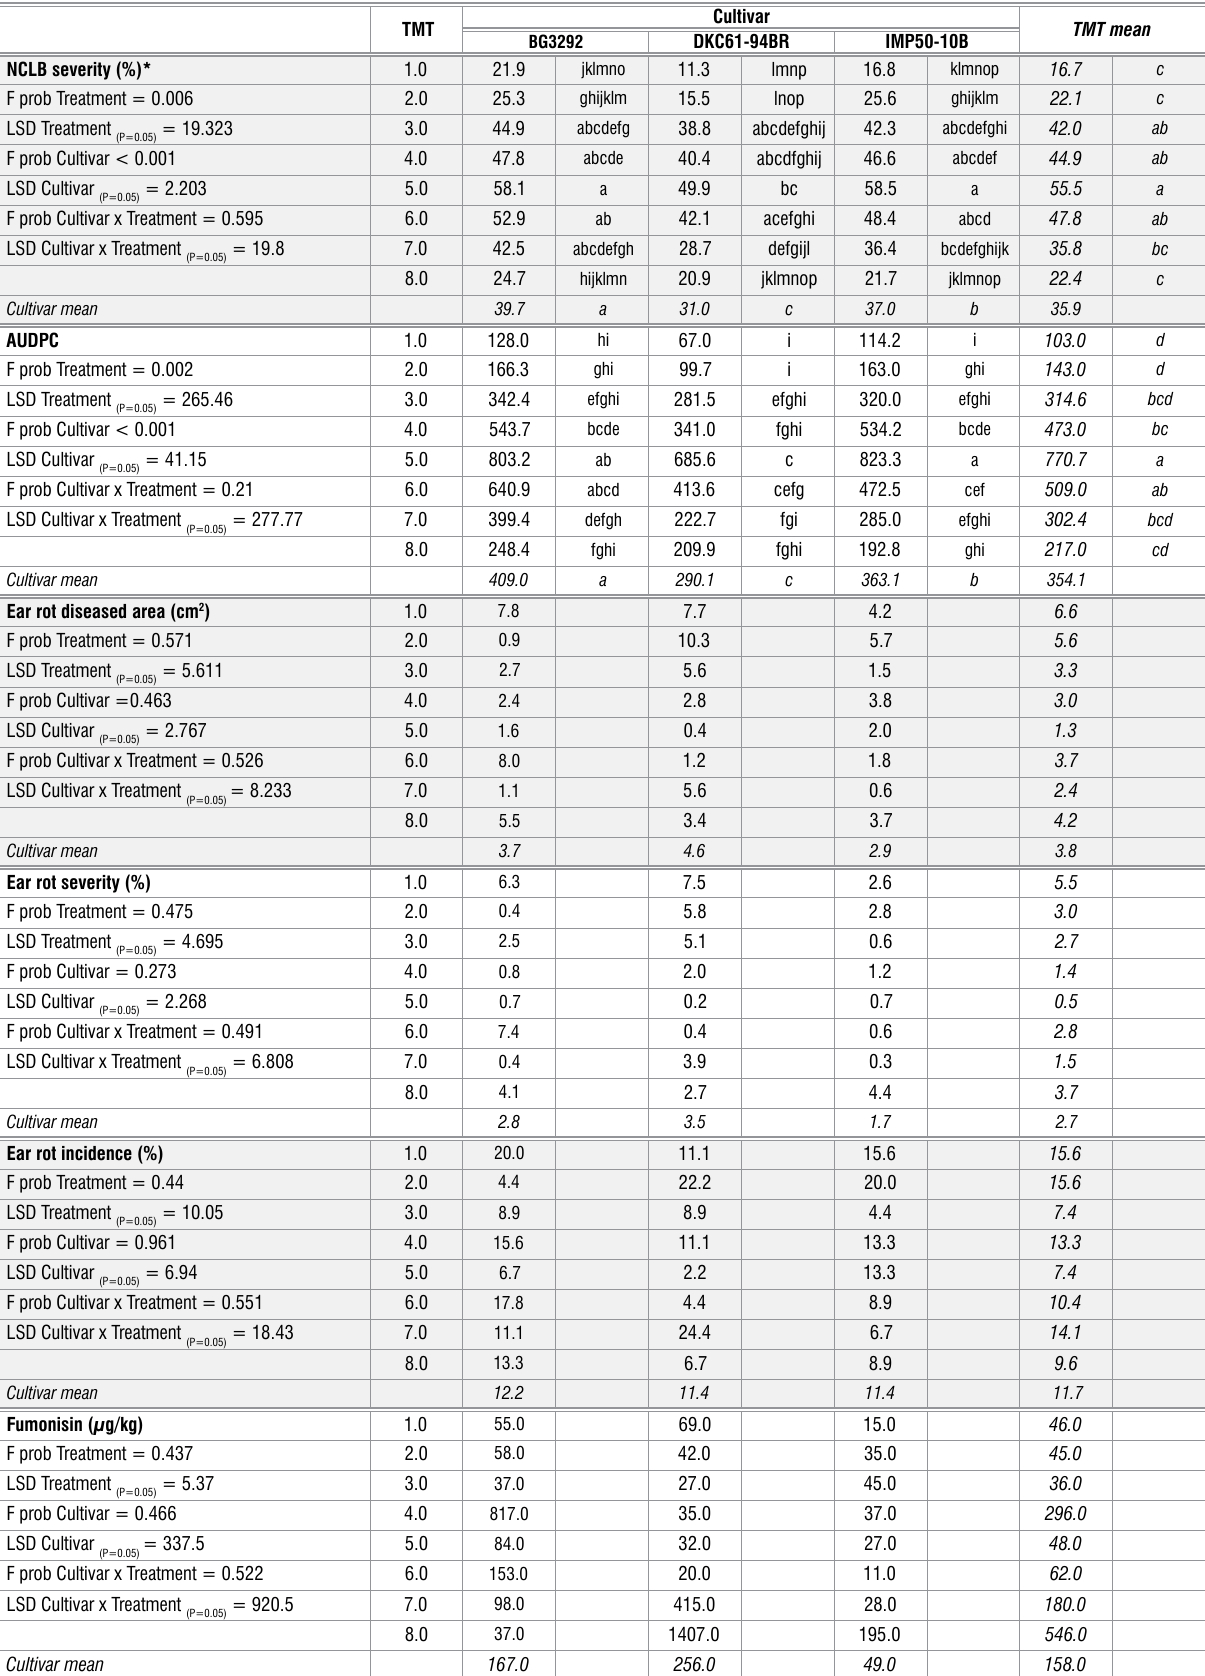
Table 5: Northern corn leaf blight (NCLB) and ear rot related data generated for the second planting trial during 2017/2018 TMT